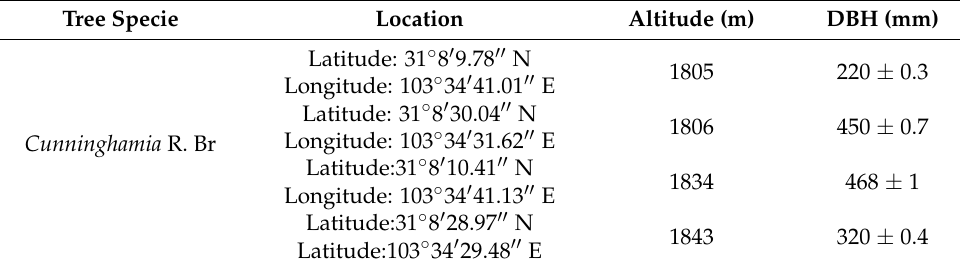
Table 1. Description of investigated trees.